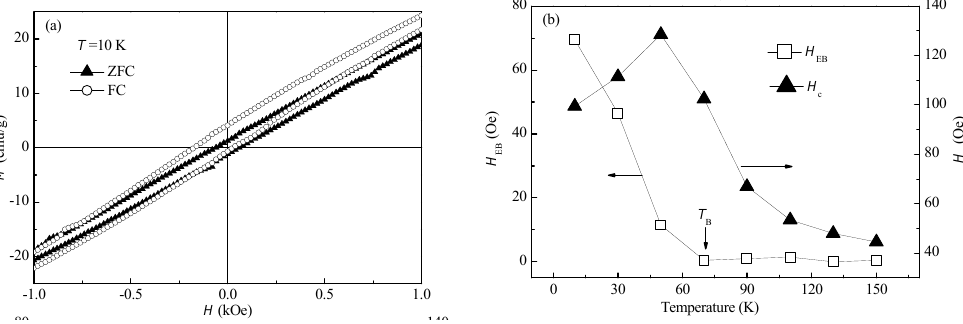
Figure 2. ( a ) Hysteresis loops of magnetization at 10 K after ZFC and FCC ( H = 10